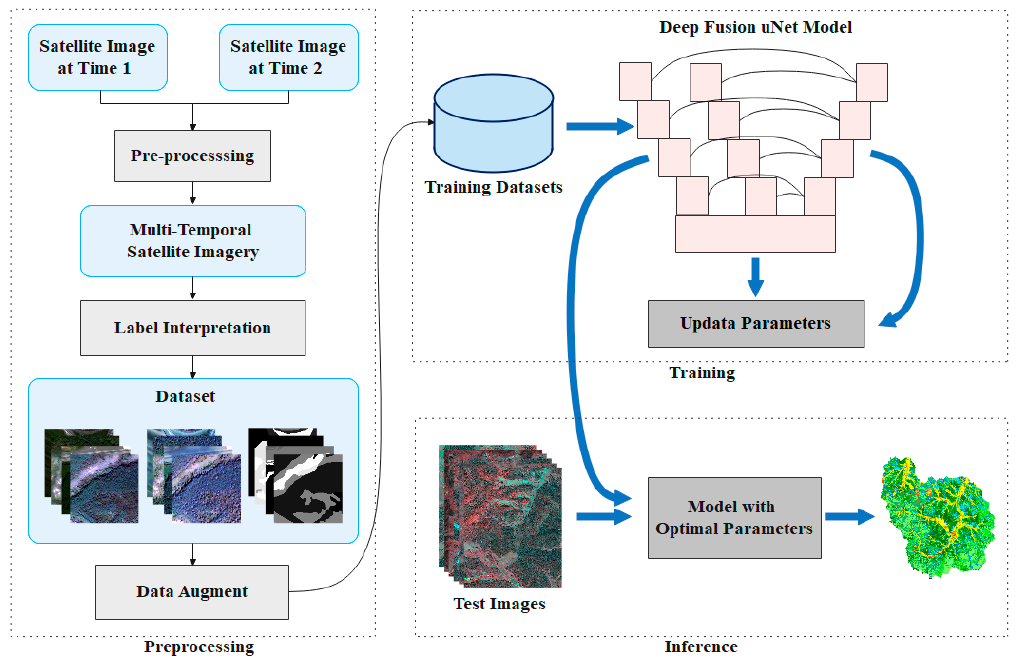
Figure 4. Workflow for the dual-uNet-Resnet model for forest type classification at tree species level based on the multi- temporal HSR image.